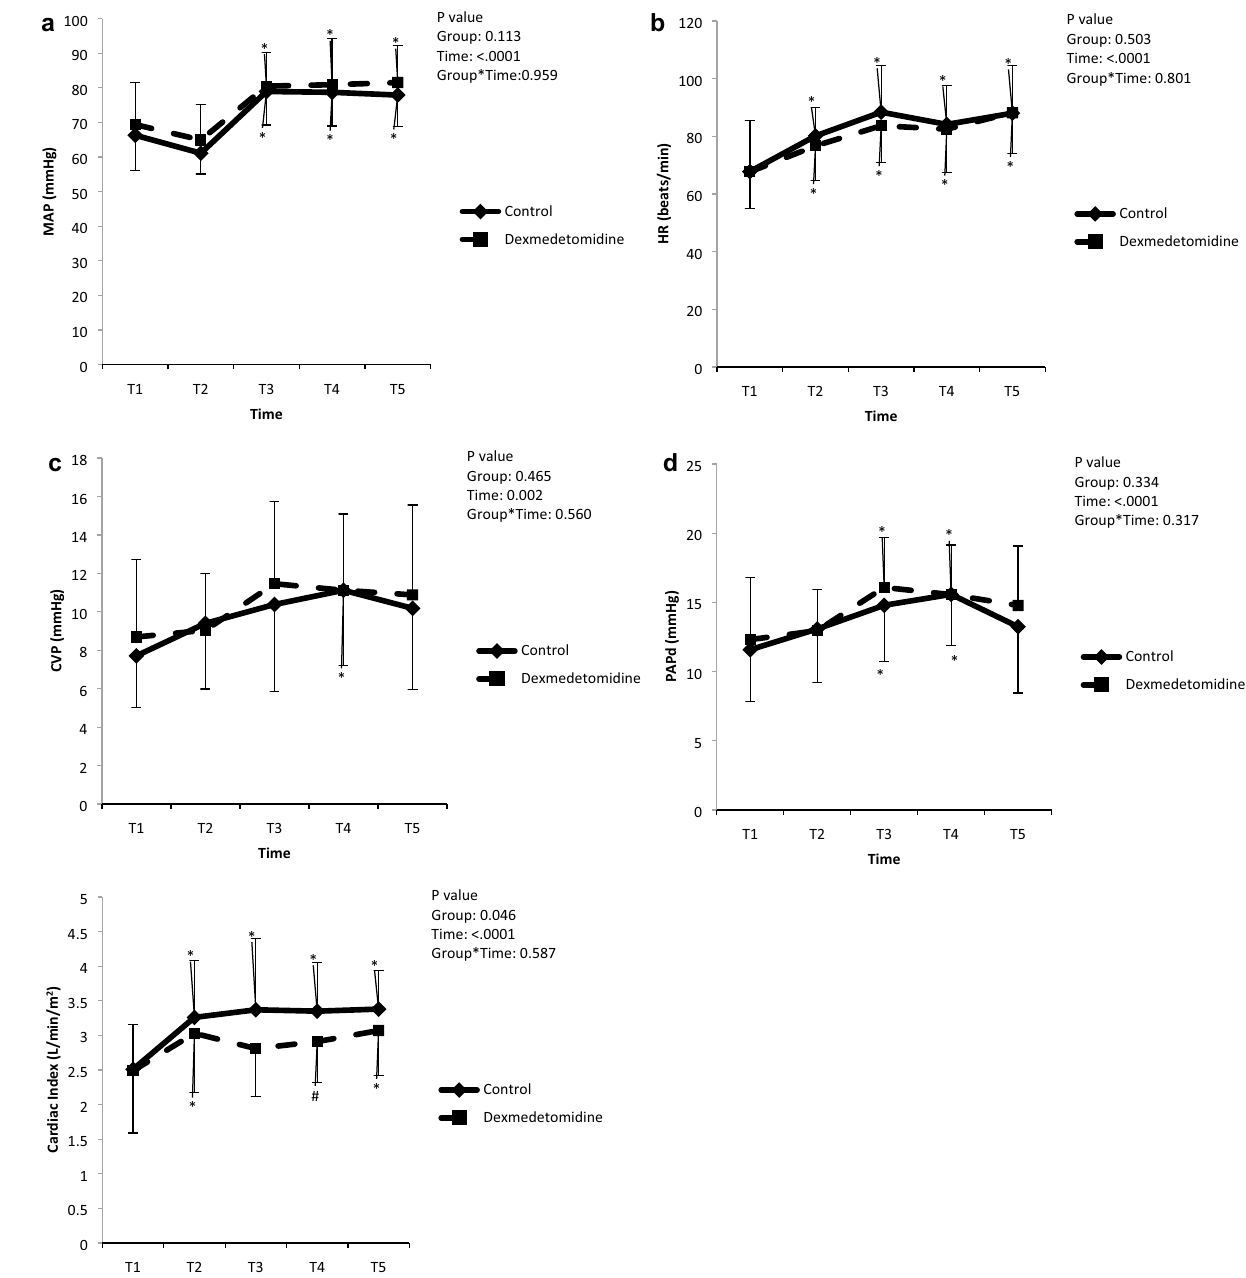
Figure 4. Changes in the perioperative hemodynamic data. MAP, mean arterial pressure; HR, heart rate; CVP, central venous pressure; PAPd, diastolic pulmonary arterial pressure; T1, post-induction; T2, ACC 1 h; T3, ACC 6 h; T4, ACC 12 h; T5, ACC 24 h. * P < 0.05 versus baseline; # P < 0.05 versus